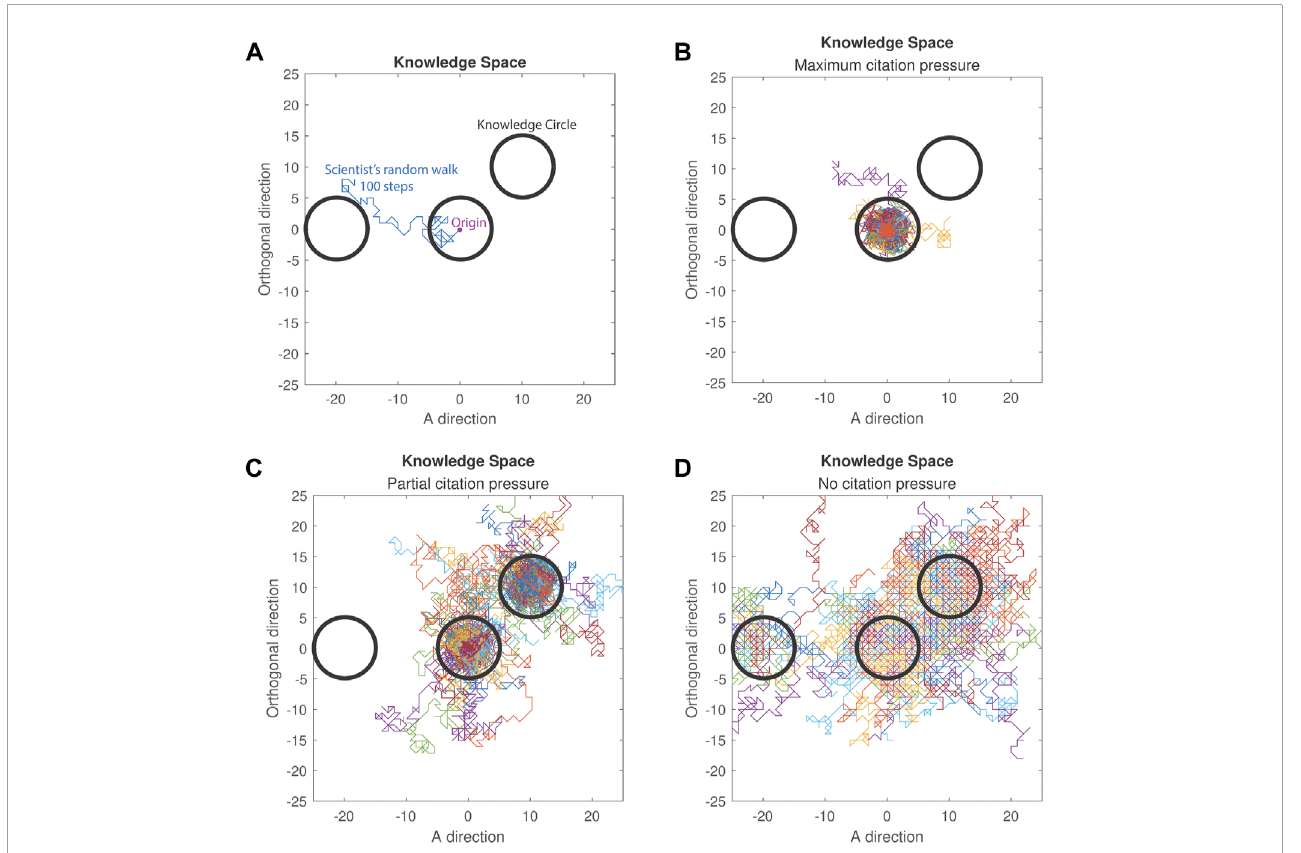
FIGURE 1 Sample runs of the thought experiment showing scientists discover more when citation pressure reduces. (A) Shows the abstract knowledge space, with knowledge circles where important breakthroughs reside, and a scientist’s random path within the space for a duration of 100 steps. (B) Simulation of 100 scientists paths with maximum citation pressure, forcing most scientists to keep exploring within their starting knowledge circle. (C) Simulation with partial citation pressure, with scientists discovering a new knowledge circle within the same simulation time frame. (D) When there is no citation pressure, scientists discover all knowledge circles within the simulation space during the same simulation